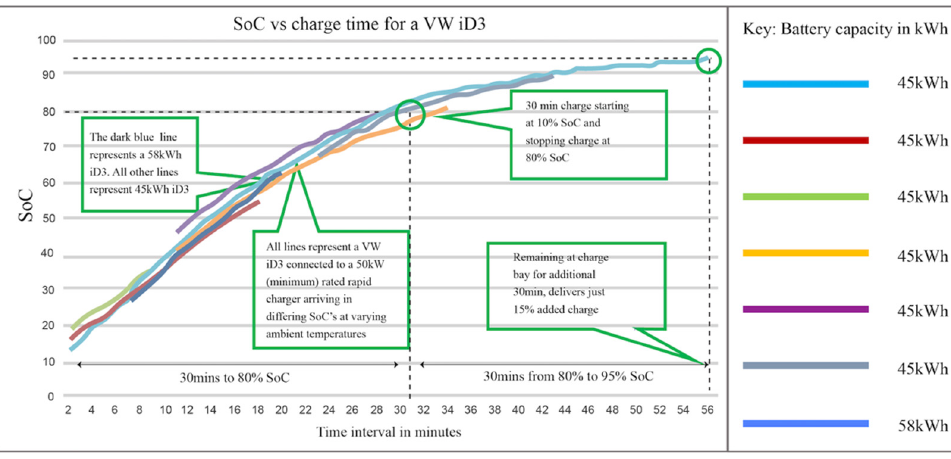
Figure 4. SoC vs. time for a Volkswagen iD3 58 kWh and 45 kWh.